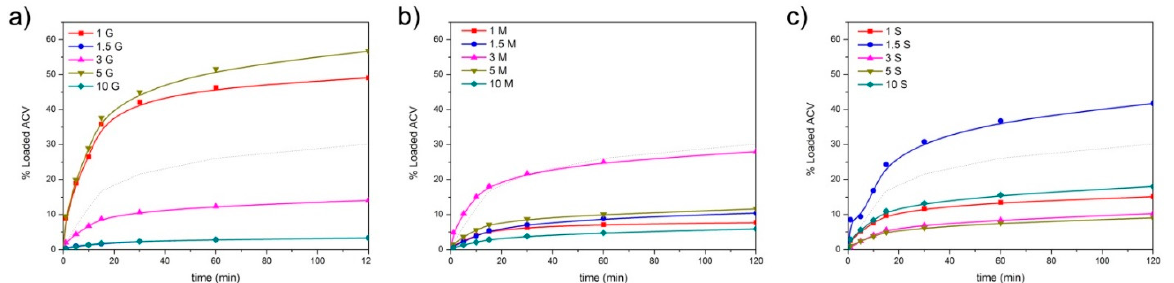
Figure 9. Release profiles of ACV in SVF functionalized with ( a ) GLYMO, ( b ) MEMO, and ( c ) MPTMS. Dotted line corresponds to the nonfunctionalized mesoporous material.